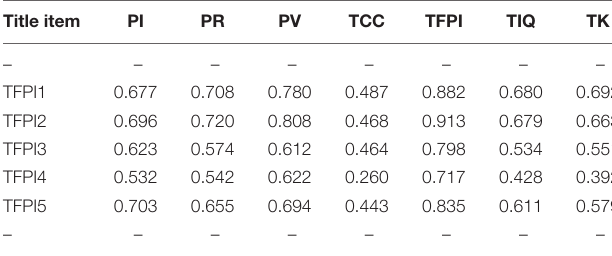
TABLE 5 | Summary table of